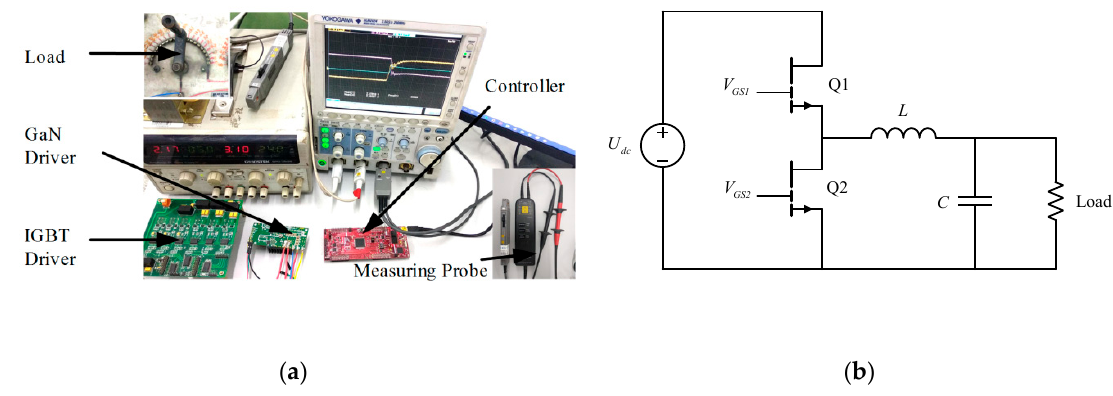
Figure 2. The experiment platform. ( a ) Photo, ( b ) Topology.